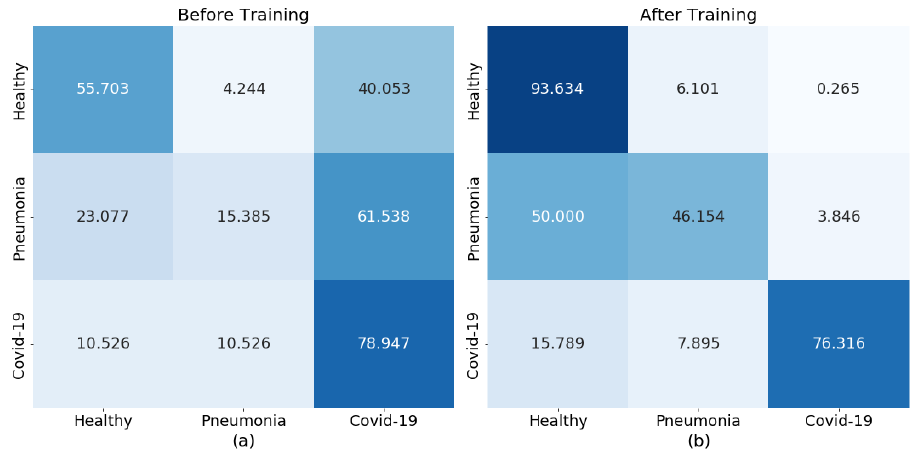
Figure 3. Prediction performance (in %) heatmaps for COVID-Net on the EHL dataset ( a ) before and ( b ) after initial